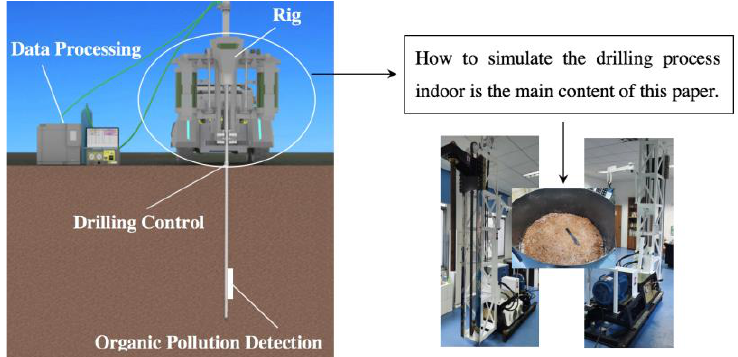
Figure 1. Drilling Control.